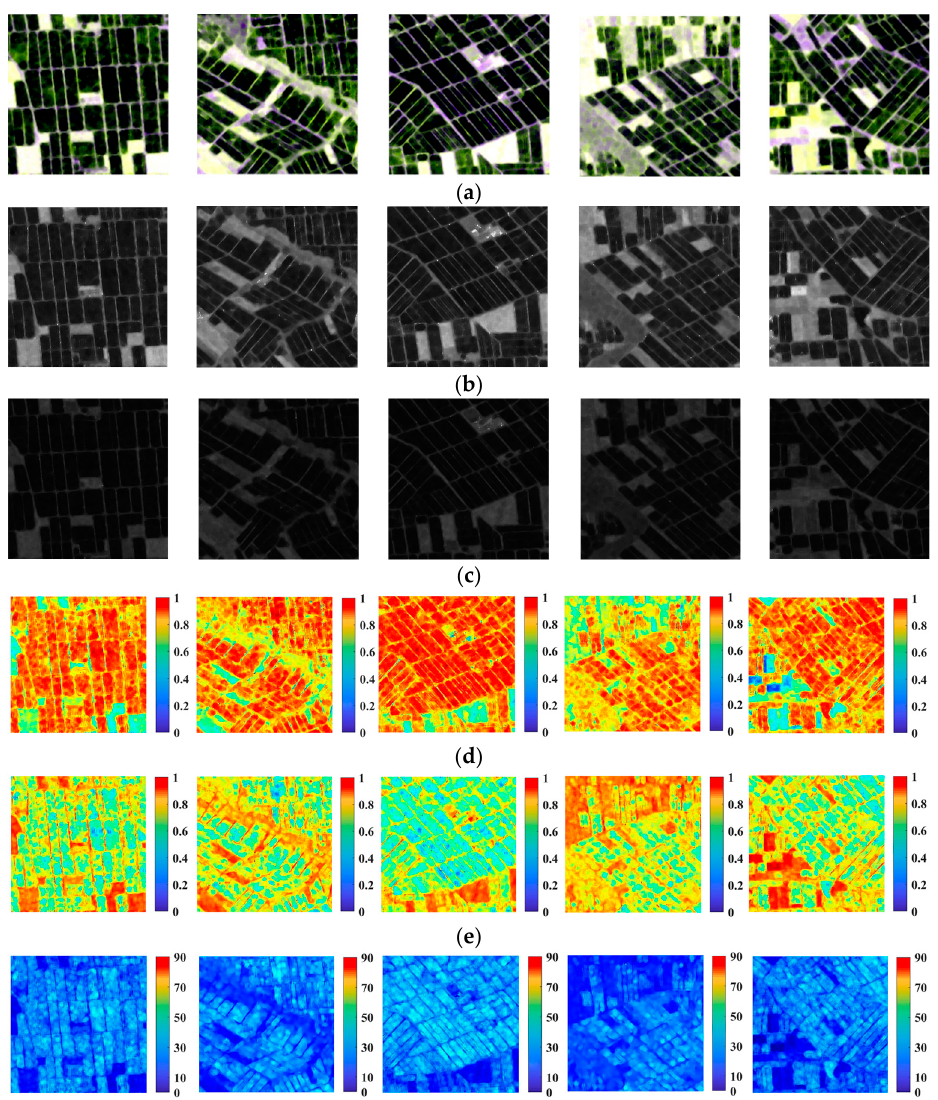
Figure 1. Sentinel-1 SAR sub-images of the Sanjiang Plain. ( a ) Pauli RGB composite images. ( b ) VV images. ( c ) VH images. ( d – f ) The corresponding polarimetric entropy images, anisotropy images, and scattering angle images, respectively.